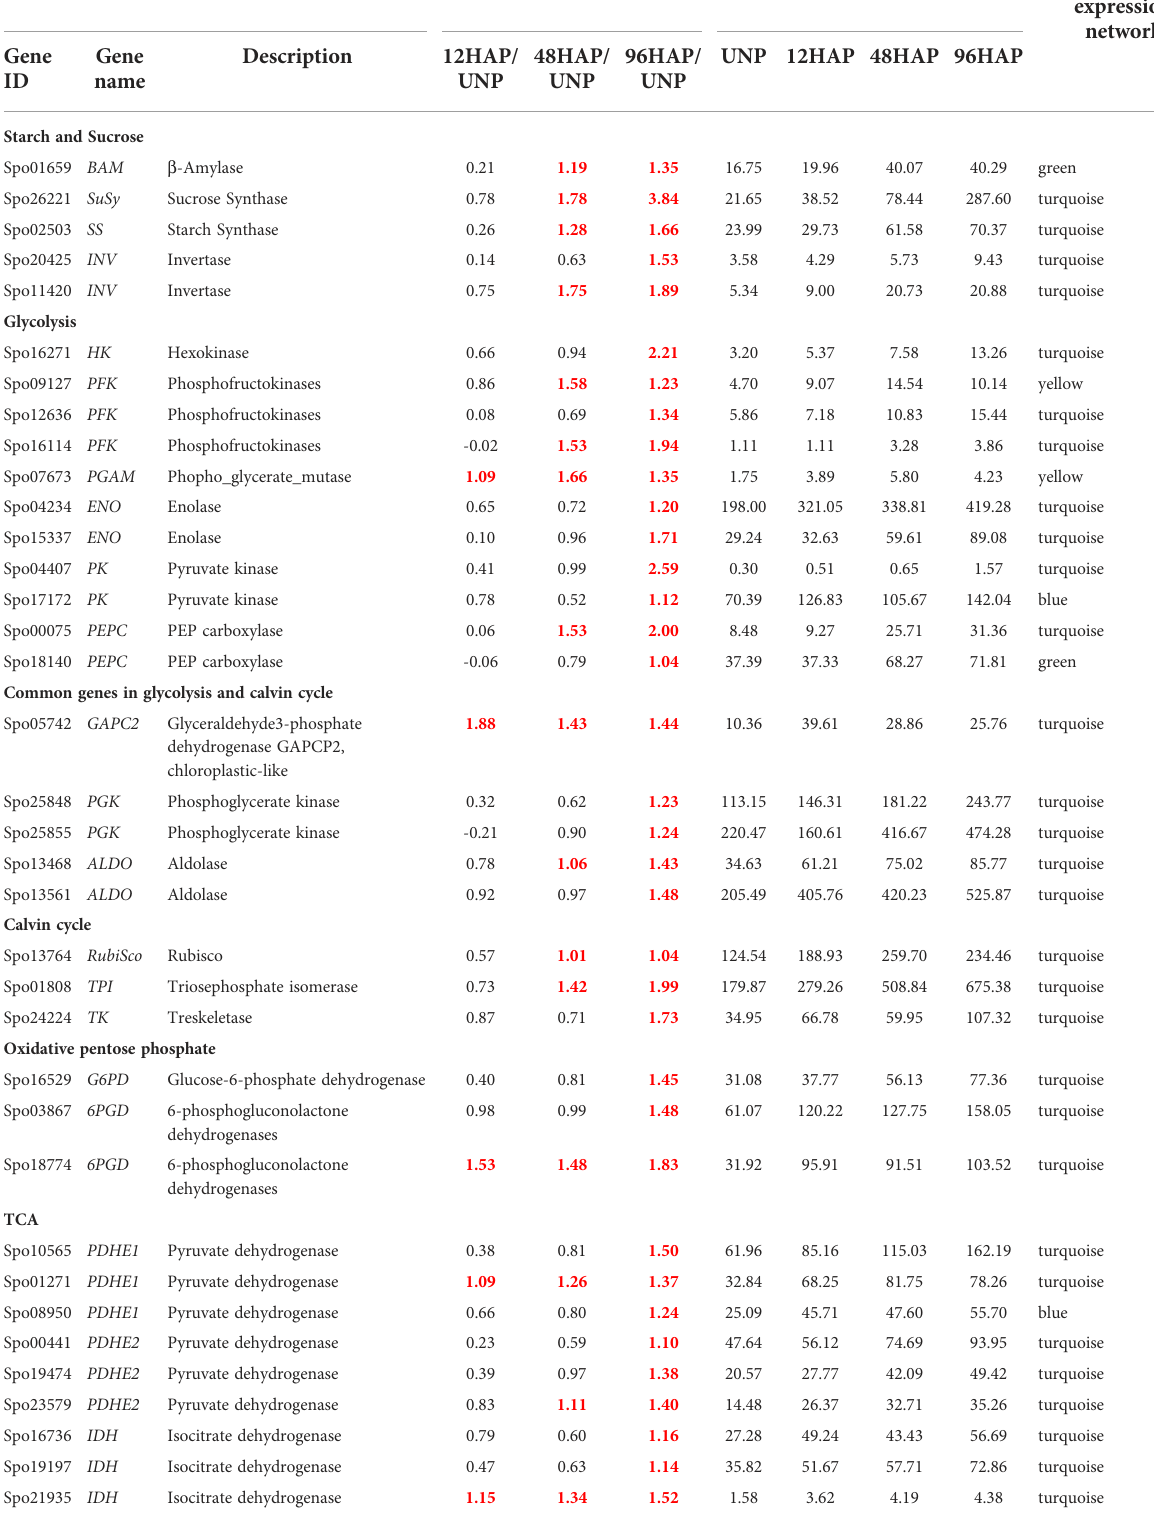
TABLE 1 Regulation of Energy-associated pathway genes in female sepal development after pollination at different time points. . Gene FPKM Modules in Co-